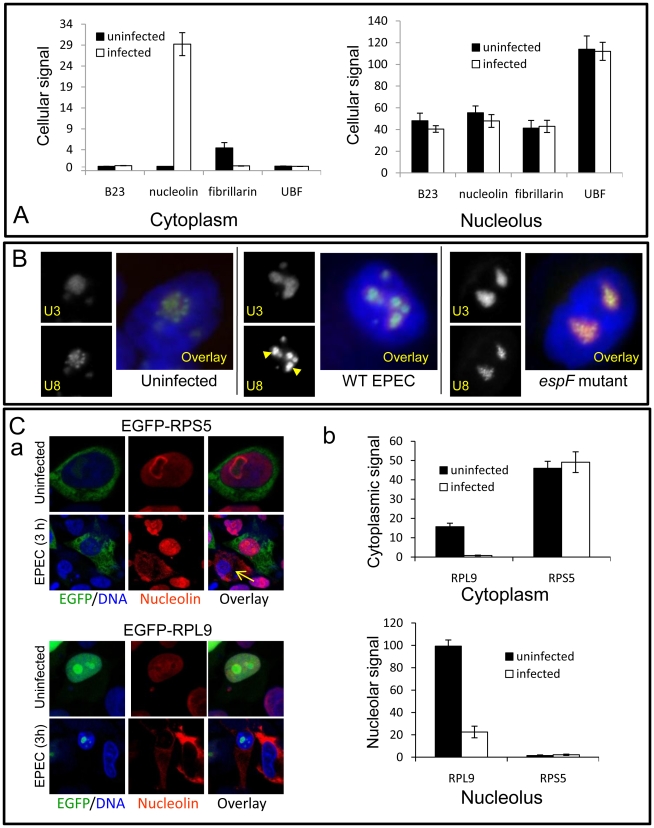
EPEC disrupts a subset of nucleolar factors.(A) Quantification of EGFP-tagged nucleolar proteins in the cytoplasm or nucleolus of uninfected or EPEC-infected (3 h) HeLa cells; bars shows mean ± SE, n = 3. There was no significant differences for any construct before or after infection (p>0.3) except for increased cytoplasmic nucleolin (p<0.0001) and decreased fibrillarin (p = 0.002). (B) Epifluorescence of U3 and U8 snoRNA antisense probes in HeLa cells infected for 3 h with wildtype (WT) EPEC or the EspF-deficient (espF) strain. Images show infected cell nuclei. Arrowheads indicate the condensation of U8 snoRNA in wildtype EPEC infected cells. (C) (a) Confocal image of EGFP-RPS5 and EGFP-RPL9 expressed in HeLa cells before and after a 3 h EPEC infection. Arrow shows a non-transfected cell stained with nucleolin. (b) Quantification of EGFP levels in the nucleolus and cytoplasm of transfected cells from (C) (a); bars show mean ± SE, n = 3.